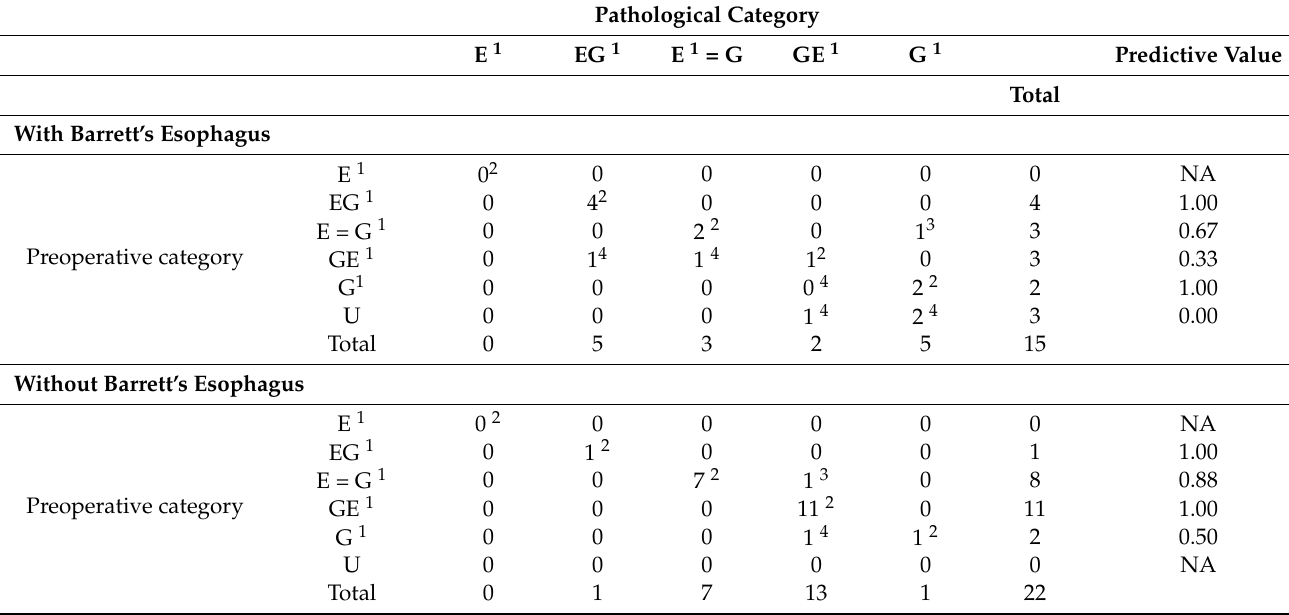
Table 4. Collation of preoperatively estimated and pathologically confirmed tumor categories in 37 EGJ cancer patients with or without concomitant Barrett’s